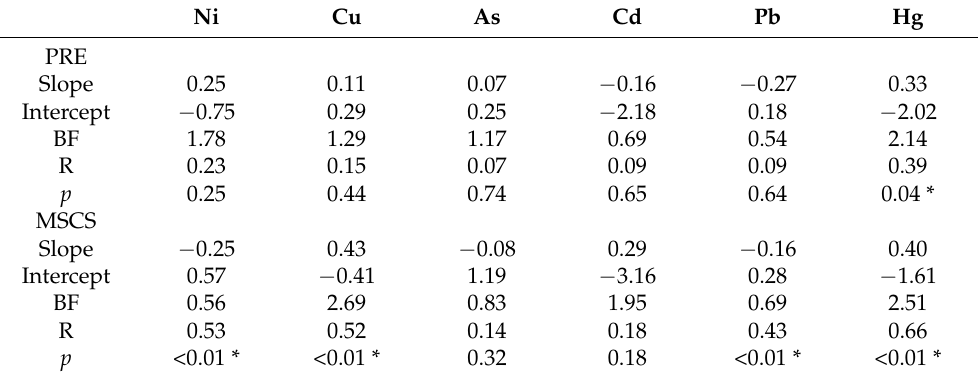
Table 3. Biomagnification factor (BF) and regression analysis (slope, intercept, correlation coefficient (R), p -value of slope) between logarithm of heavy metal concentrations and trophic levels for fish collected in Pearl River Estuarine (PRE) and the middle of the South China Sea